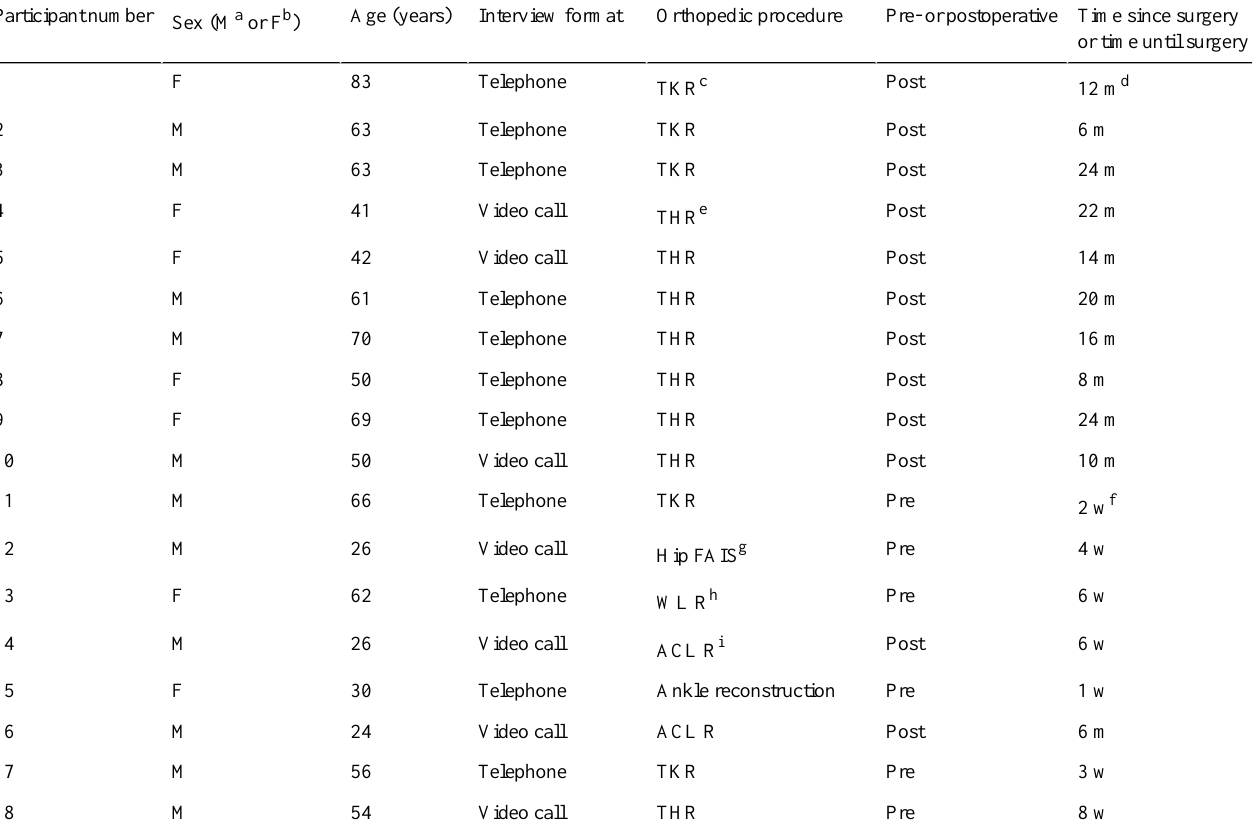
Table 1. Participant characteristics.